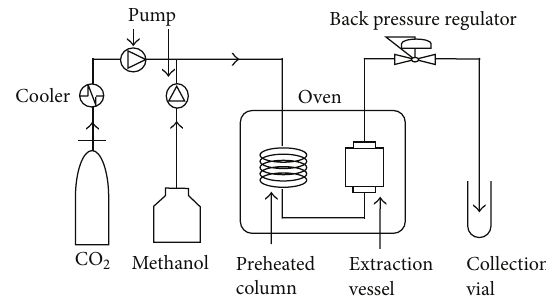
Figure 1: Schematic diagram of supercritical fluid extraction (SFE) apparatus for quinones